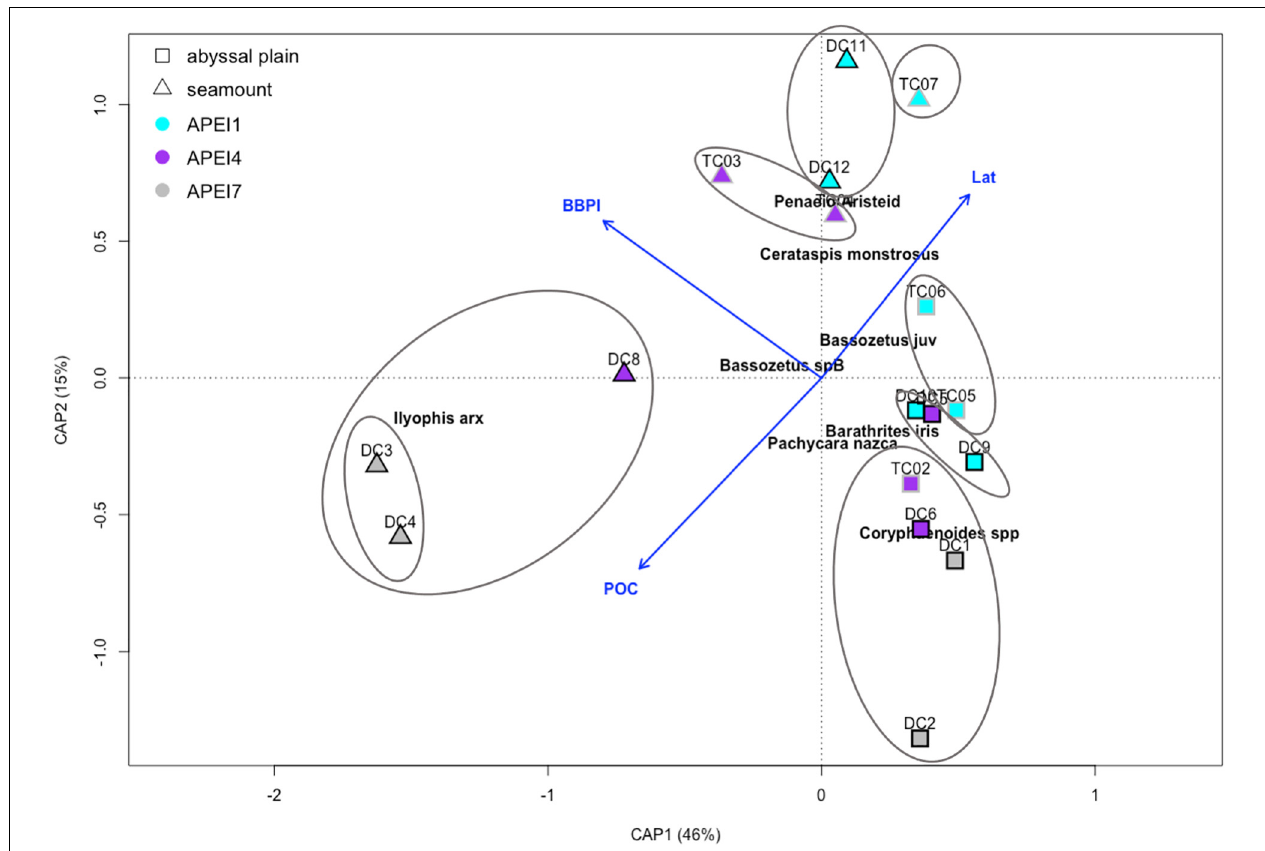
FIGURE 7 | Constrained ordination of square root transformed abundance data (MaxN). Blue arrows with labels represent the biplot scores for each constraining variable. Marker shape denotes habitat type (triangle = seamount; square = abyssal plain), fill color denotes APEI, outline color denotes lander (Deepcam, black outline; Tripod, gray outline). Proportion of variation explained by each axis is in parentheses. Species names show the most influential species as identified by SIMPER analysis with a cumulative contribution to the ordination of 0.72. Circles show significant (alpha = 0.05) clusters of deployments as determined by similarity profile